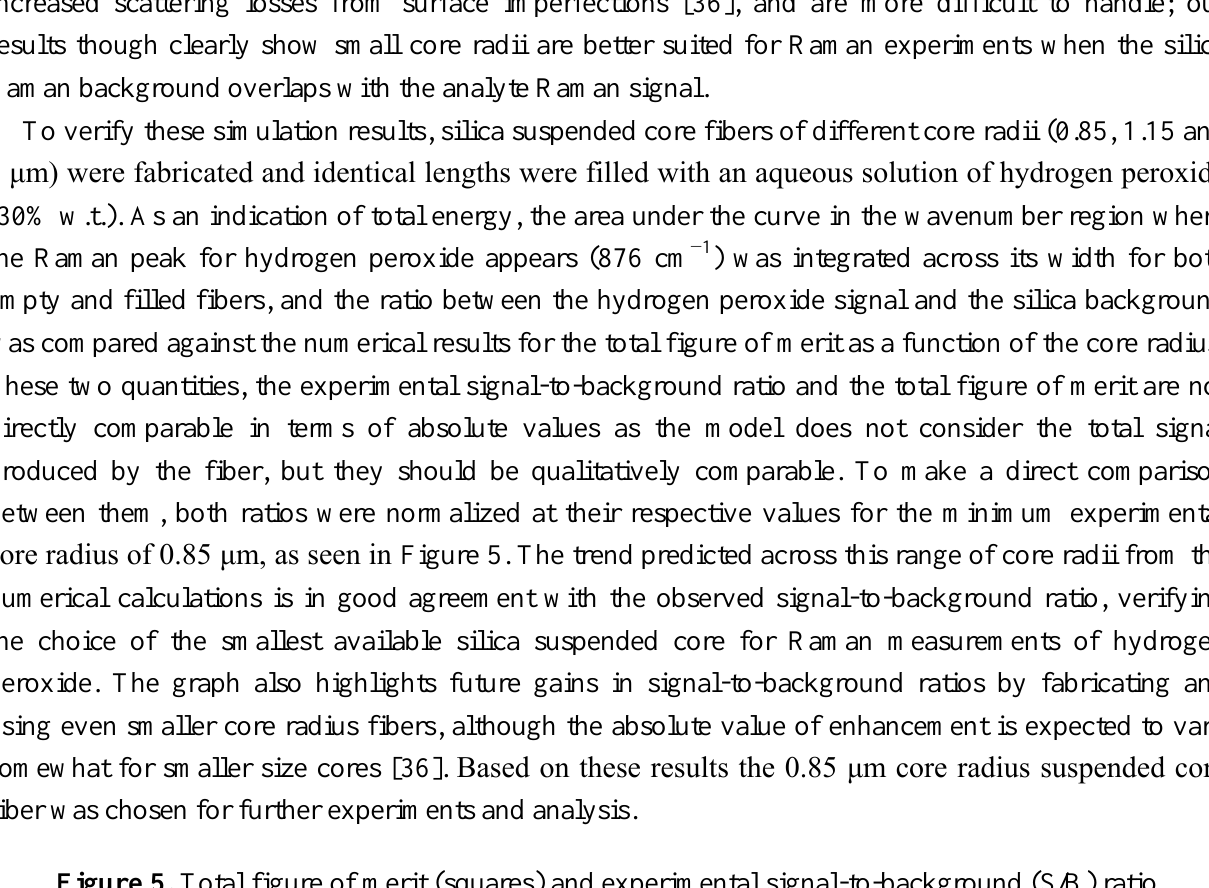
Figure 5. Total figure of merit (squares) and experimental signal-to-background (S/B) ratio (circles), normalized at a core radius of 0.85 μm for ease of comparison, as a function of core radius. The graph also shows the expected improvement in signal-to-background ratio for smaller core